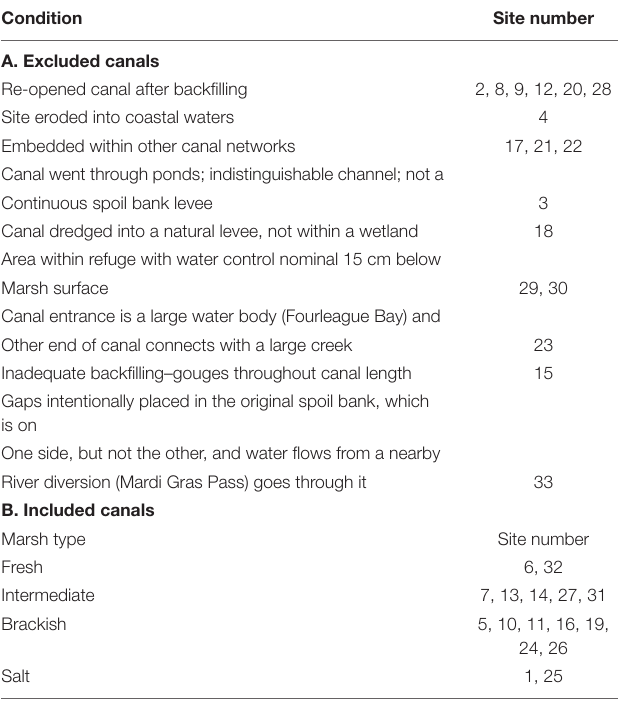
TABLE 1 | Canals excluded (A) and included (B) in the